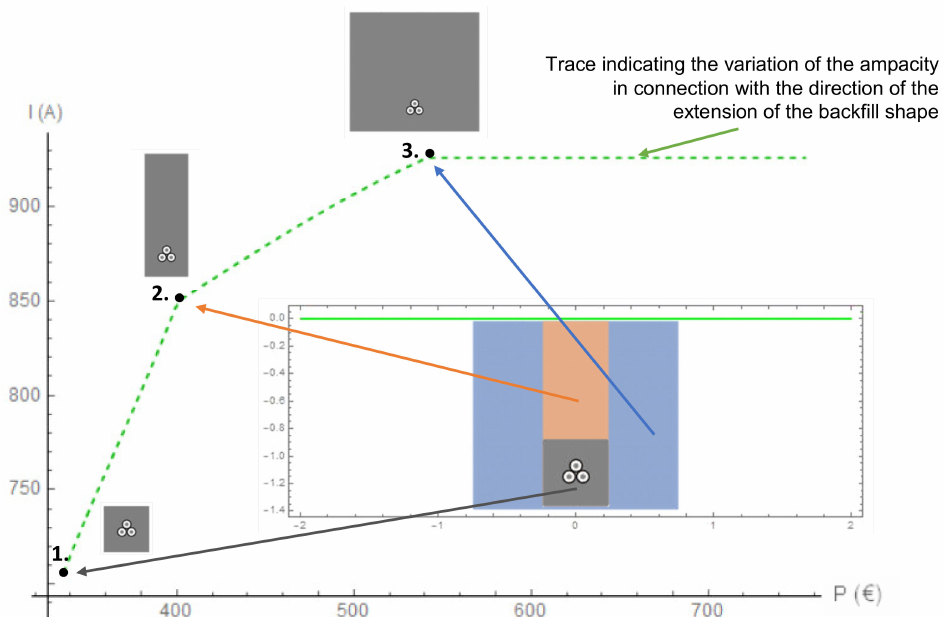
Figure 5. Ampacity I of the power cable line as a function of the cost P of the line performance and the backfill geometry; 630 mm 2 cables laid in the trefoil formation. Characteristic points: (1) I = 706 A (the smallest backfill area); (2) I = 851 A; (3) I = 926 A (the largest backfill area). Thermal resistivities: ρ e = 2.5 (K · m)/W, ρ c = 0.6 (K ·